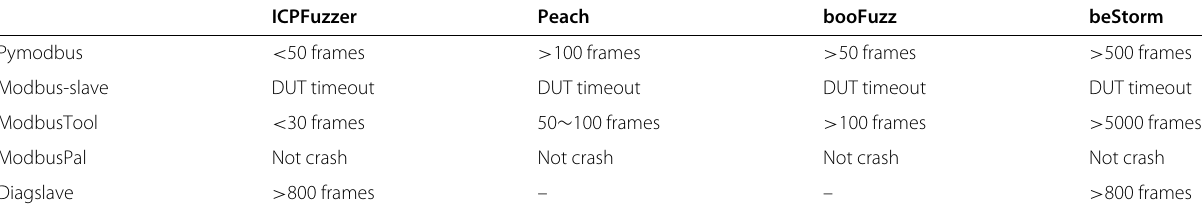
Table 6 Comparison of the number of frames of different fuzzers before the DUT crashed ICPFuzzer Peach booFuzz